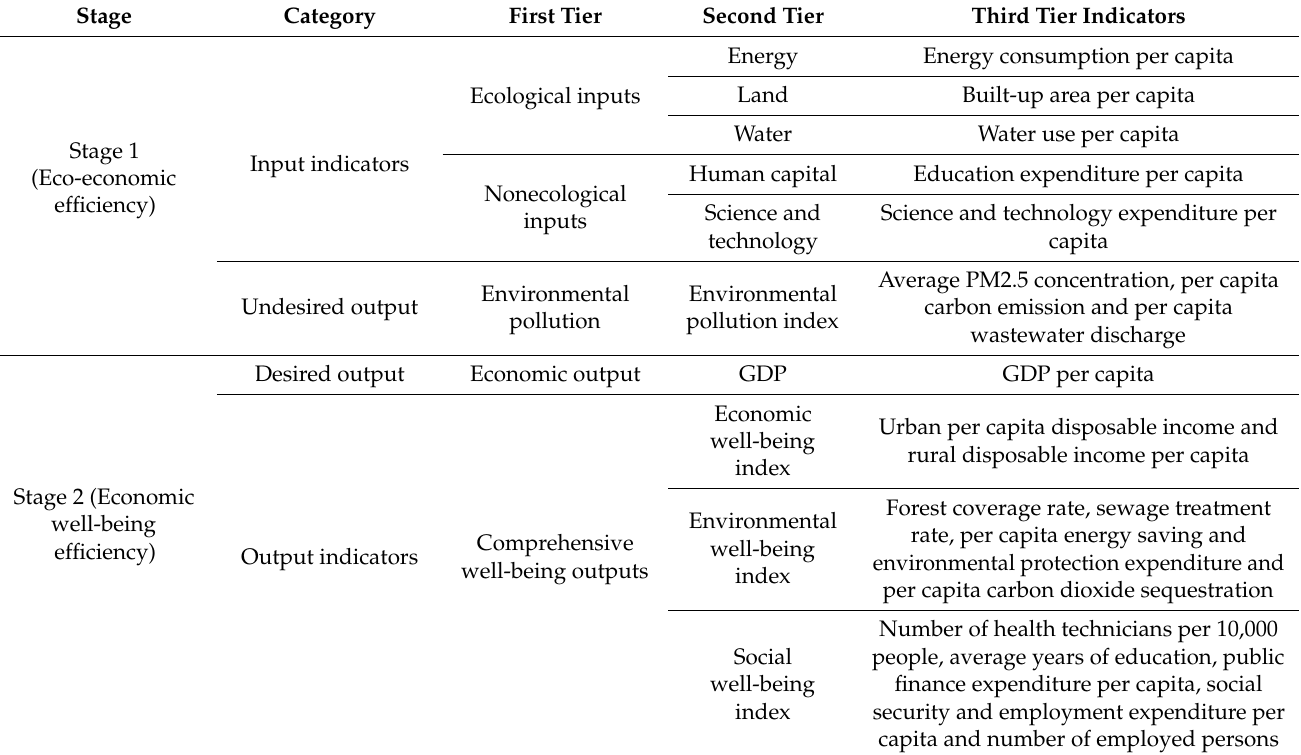
Table 1. Evaluation index system of EWP in the Poyang Lake